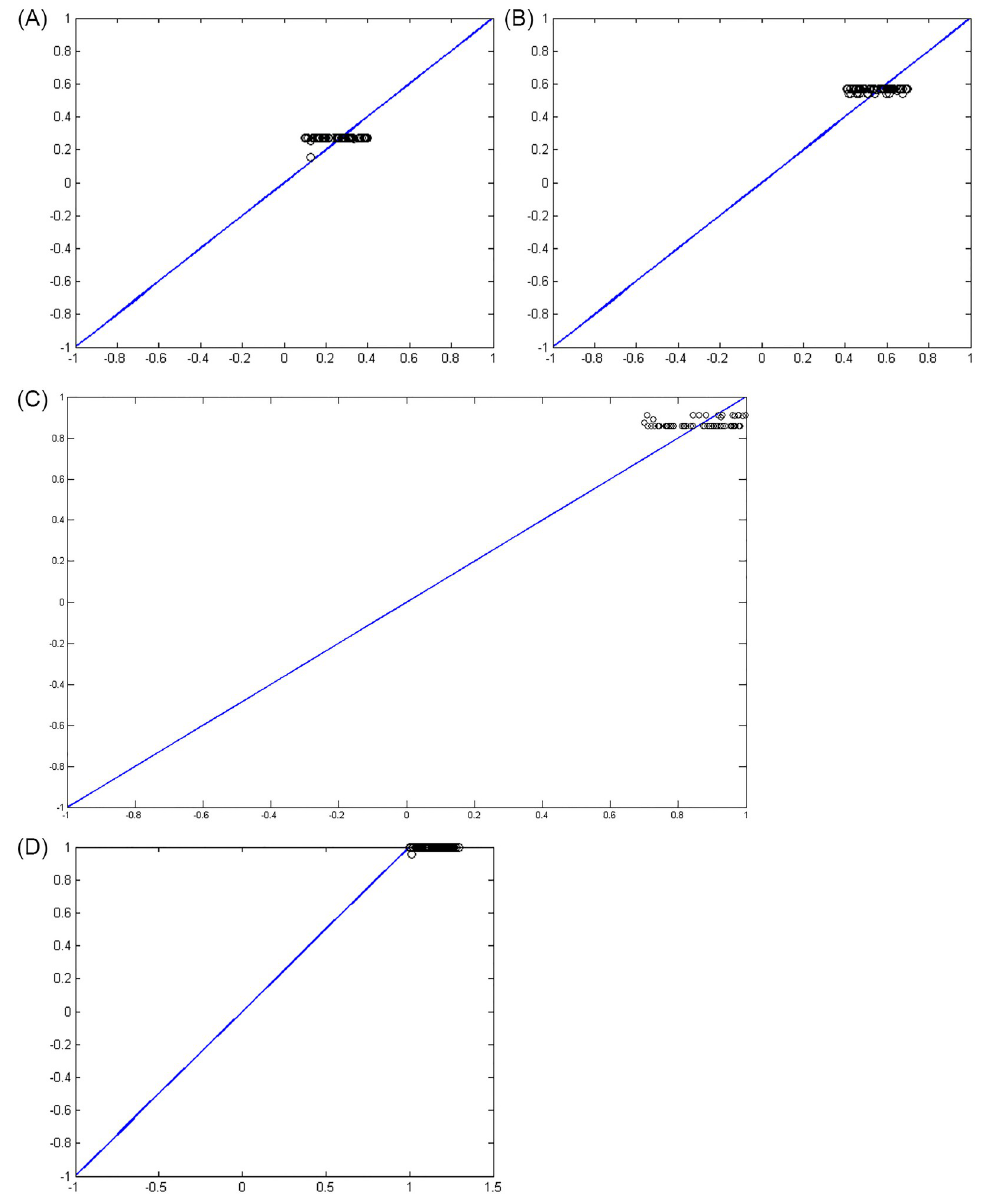
Fig 7. The distance between the real answers and the regression line (regression function) obtained with ANN-BTA in the training samples: (Fig 7A)[0.1, 0.4], (Fig 7B)[0.4, 0.7], (Fig 7C)[0.7, 1] and (Fig 7D)[1, 1.3] range.